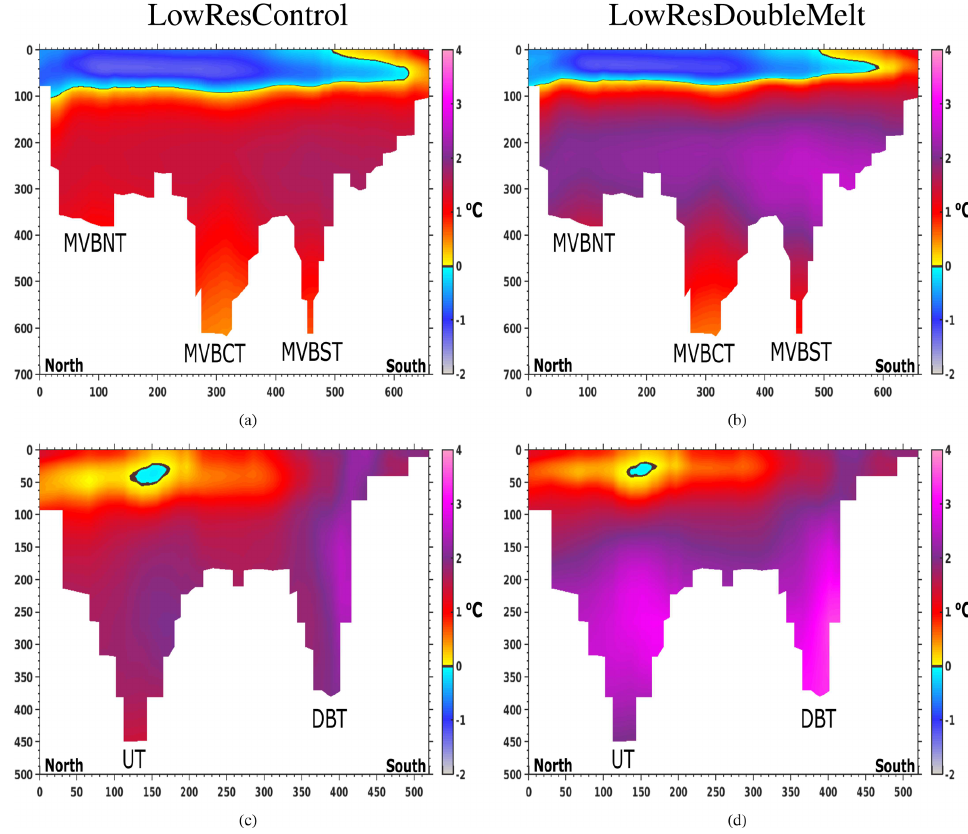
Figure 12. Temperature along two sections in the northwest of Greenland, the Melville Bay section and Disko Bay section. For the location of these sections, see Fig. 1. Shown is the average temperature over the period of 2004 to 2016, with the model bathymetry in white (m) and the colours indicating the temperature of the water in ◦ C. The left column (a, c) shows the results for LowResControl, and the right column (b, c) shows the results for LowResDoubleMelt. The first row (a, b) shows the Melville Bay section, and the second row (c, d) shows the Disko Bay